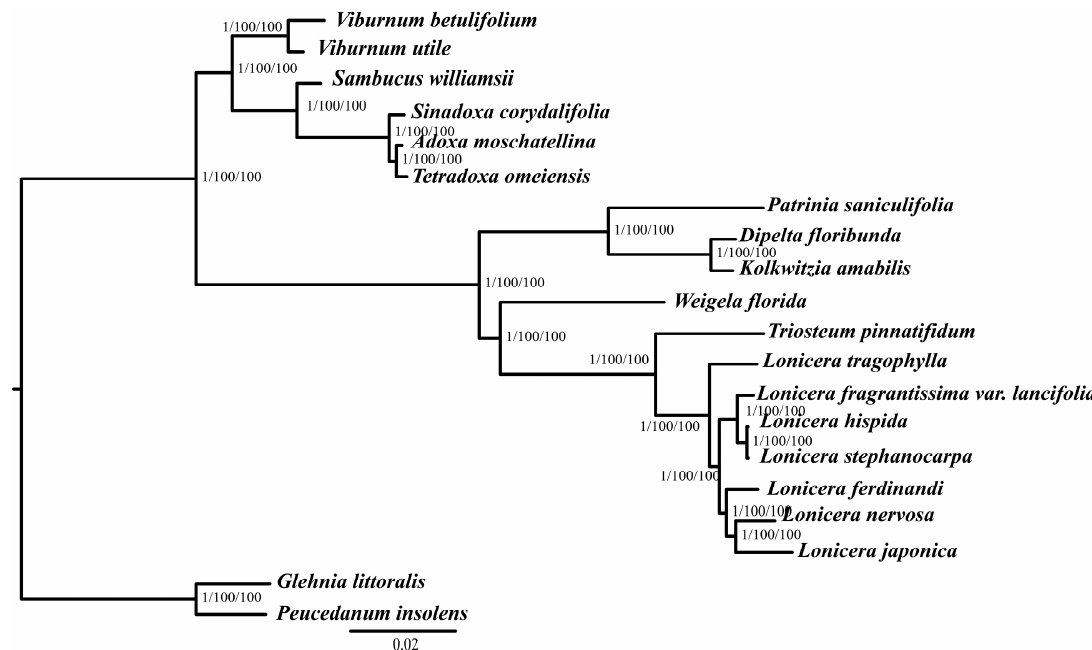
Figure 7. Phylogenetic tree obtained for seven Lonicera species based on the complete chloroplast genomes. The first number of the slashes on the branches shows the posterior probabilities according to Bayesian inference, the second number shows the bootstrap values obtained by maximum likelihood analyses, and the third number shows the bootstrap values obtained by maximum parsimony analyses.